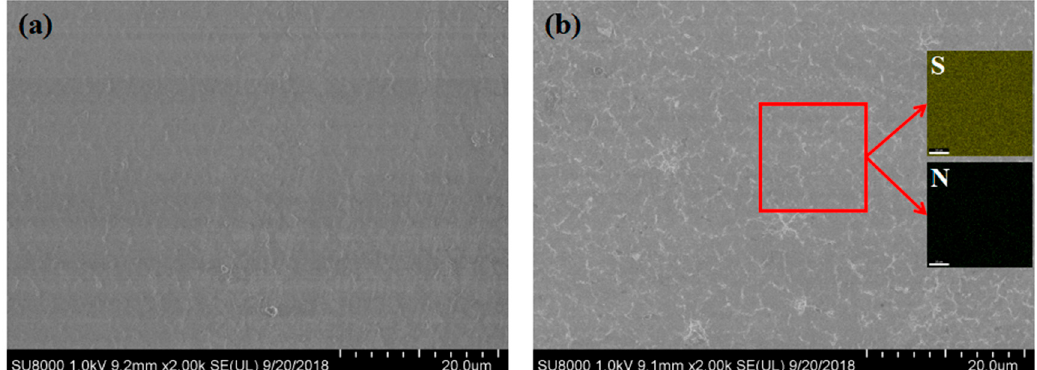
Figure 5. SEM image of surface morphology of EVOH film ( a ), and SEM image and EDS mapping of surface of AIEM (GY = 40.9%) ( b ).